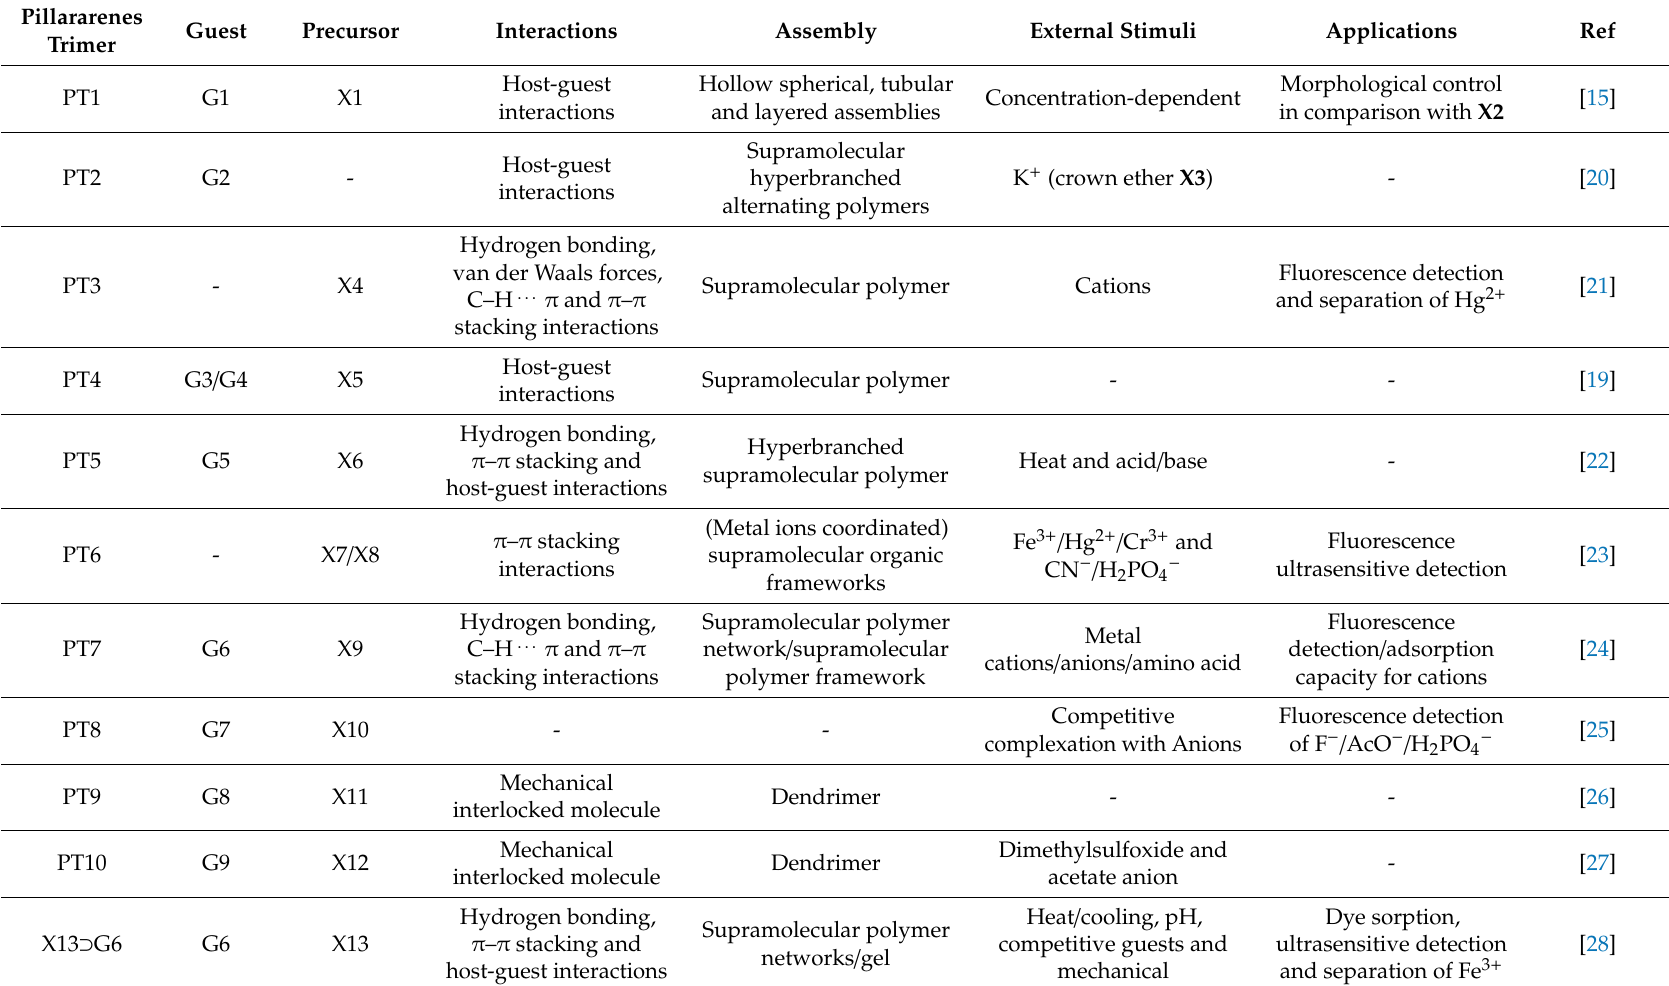
Table 1. Comparison of various pillararenes trimer ( PT1 – PT10 ), guest molecules ( G1 – G9 ), precursors, and other significant building blocks ( X1 – X13 ) for self-assembly and external stimuli